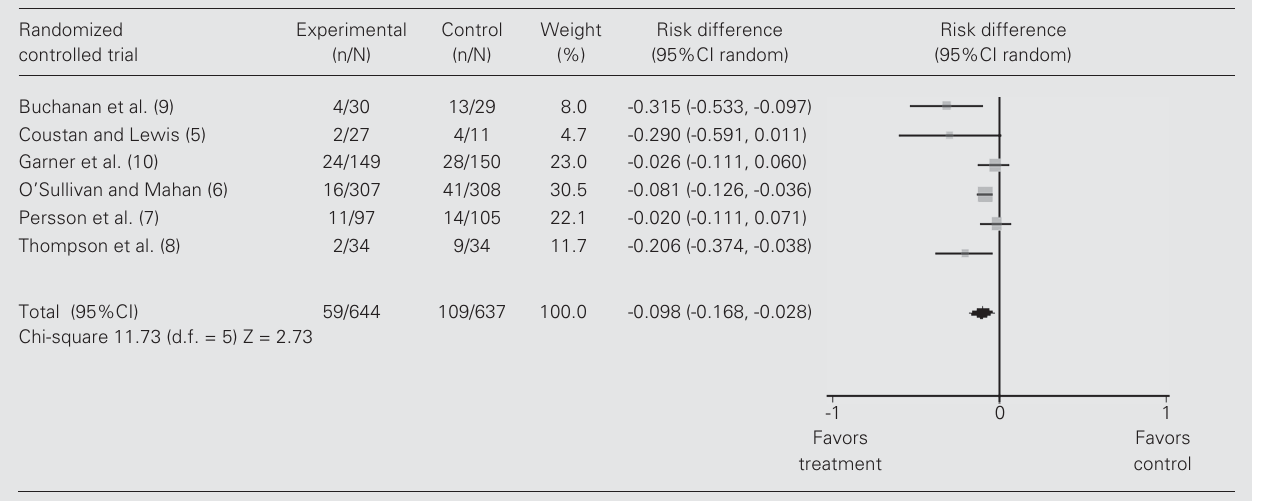
Comparison: diet vs diet + insulin. Outcome: macrosomia. CI = confidence interval; n = number of macrosomic newborns observed; N = number of individuals treated in each